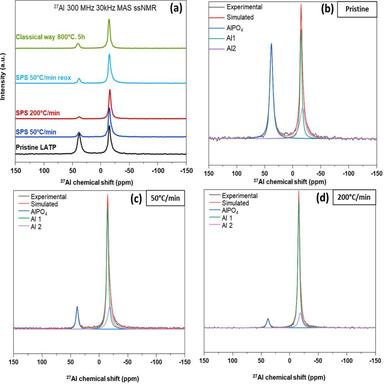
27Al NMR spectra of the pristine powder LATP, samples sintered by SPS and conventional annealing, and re-oxidized sample (a) and the deconvolution of the spectra collected for pristine LATP (b), SPS 50 ◦C/min (c) and SPS 200◦/min (d). The experimental and simulated spectra are displayed as black and red lines respectively. The simulated spectra are the sum of distinct line shapes displayed in blue, green and purple lines.